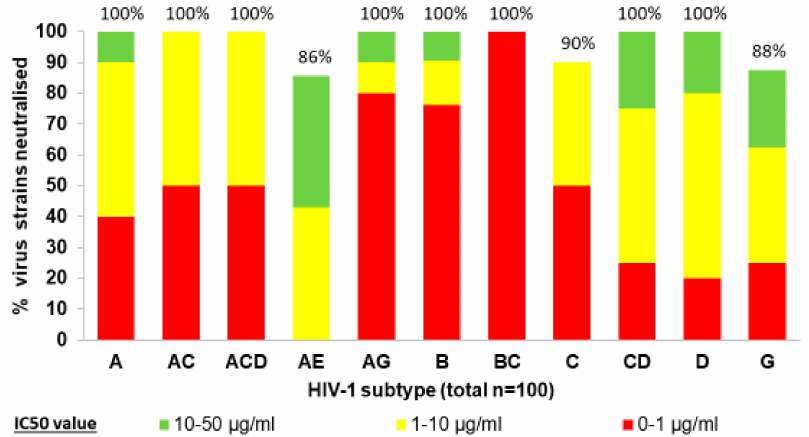
Figure 3. Potency of neutralization by CD4bs nanobody J3. Ninety-six of 100 HIV-1 pseudoviruses of various subtypes and circulating recombinant strains were sensitive to neutralization. Reproduced with permission from McCoy et al.